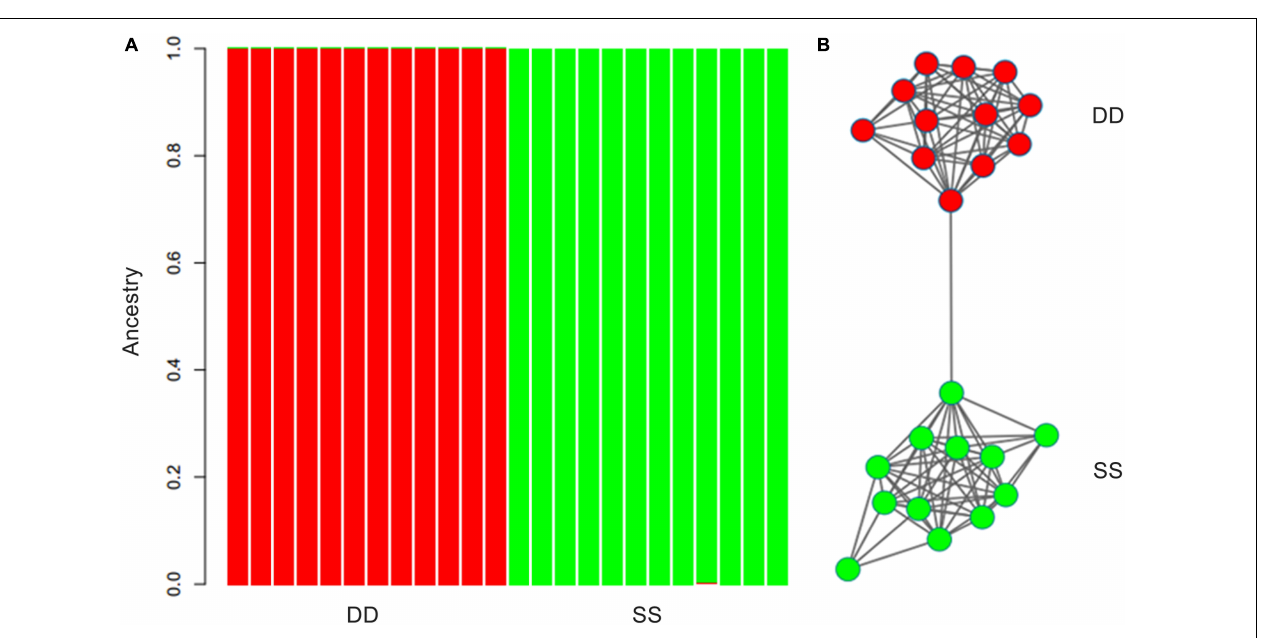
FIGURE 2 | Results of ADMIXTURE (A) and NETVIEW (B) based on outlier